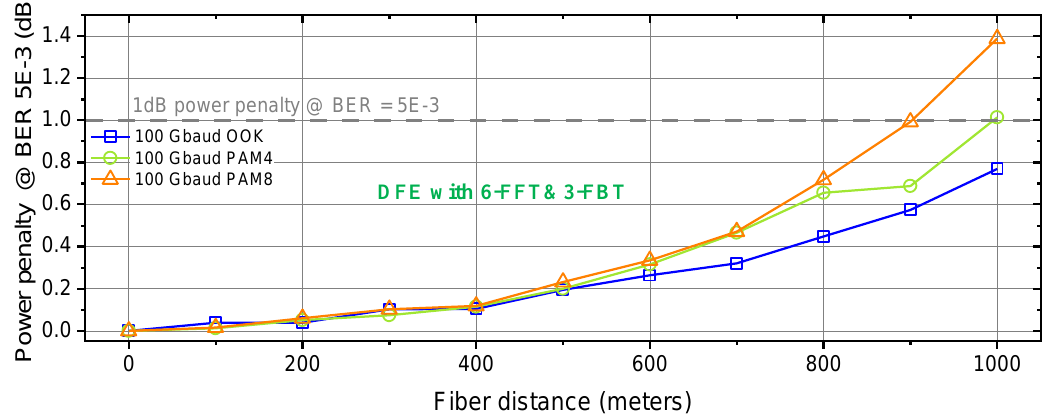
Figure 7. Received power penalty (at BER = 5E-3) as a function of transmitted distance for 100 Gbaud OOK, PAM4, and PAM8 signals with 6-FFT and 3FBT equalizer configuration (see inset).